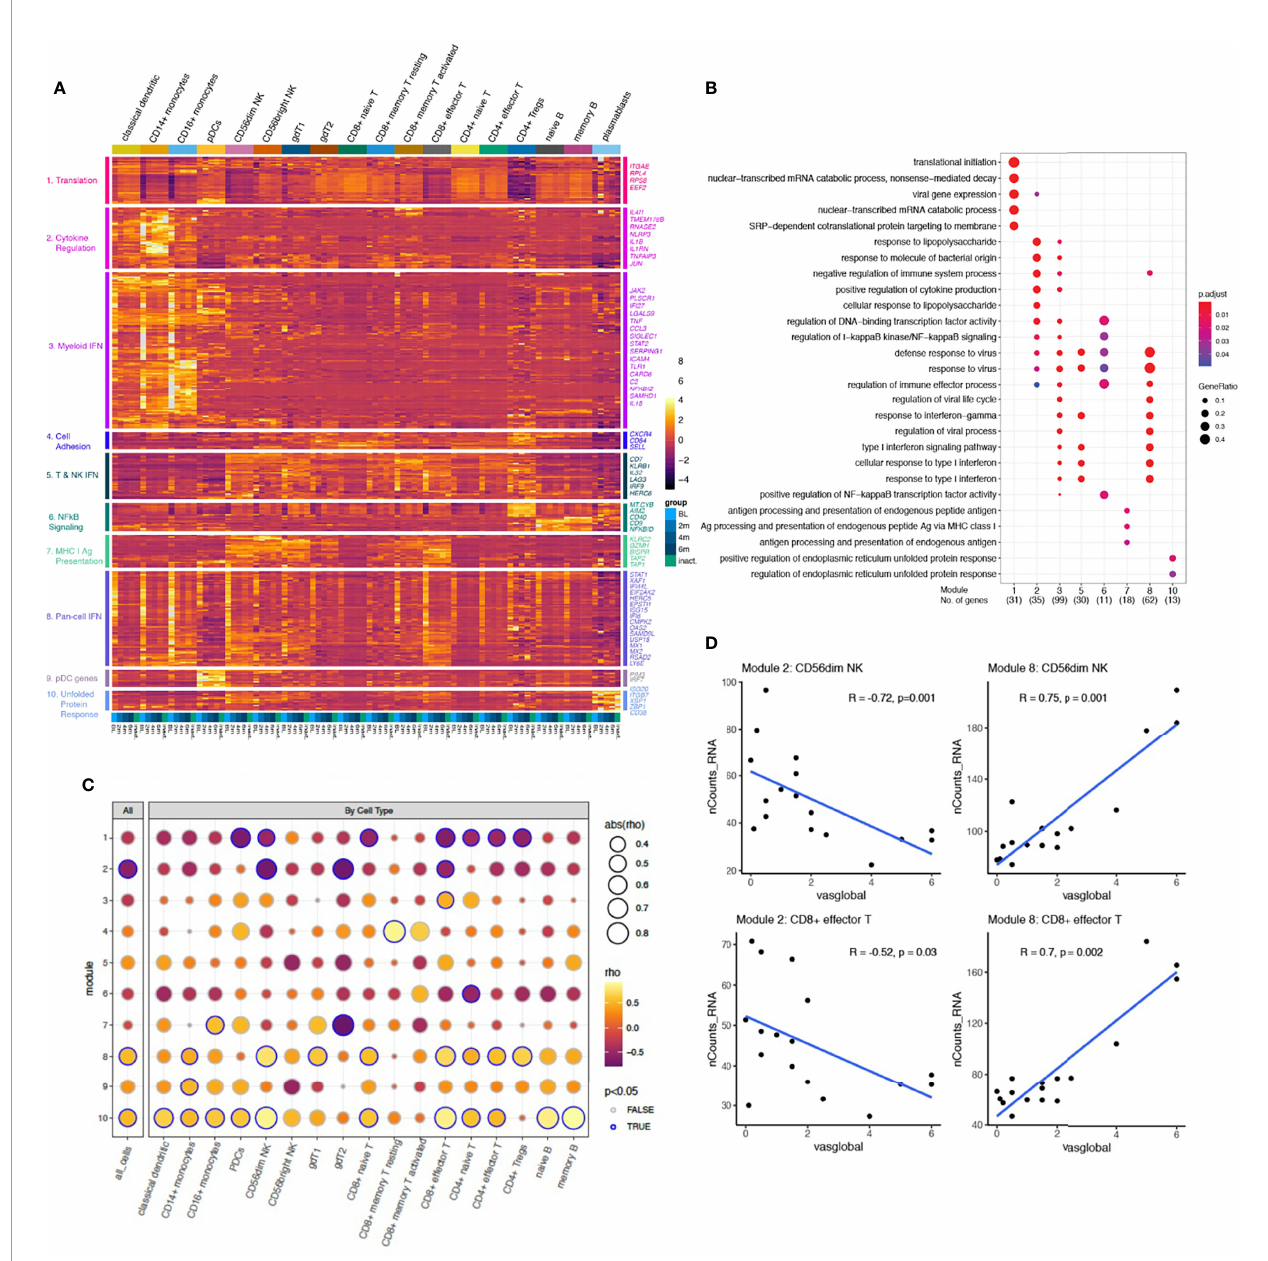
FIGURE 3 | (A) A heatmap displaying the mean expression of 368 genes differentially expressed in at least one cell type for each group per cell type ordered by increasing time from diagnosis (BL, 2m, 4m, 6m, inactive). Rows are clustered using unsupervised hierarchical clustering with k=10, and modules are annotated by enrichment terms on the left. A selection of genes from each module is annotated on the right. Color represents the normalized mean expression. (B) A dotplot displaying the association between each gene module set and enrichment of GO Biologic Processes terms. Each column represents a module from panel (A) . Enrichment analysis was performed using over-representation analysis with the color representing the adjusted p-value using B&H and the size of the dot representing the ratio of the number of genes relative to the number of genes in each term. (C) A dotplot displaying the strength of correlation between each module gene score, calculated as the average expression of all genes within a module, and the physician global VAS score for all cells together (left column) and each cell type individually. The correlations were calculated using a Pearson correlation. The size of each dot represents the strength of the association, the color represents the direction of the association, and the outline of the circle indicates signi fi cance de fi ned as P-value <0.05. (D) The Pearson correlation between the module gene score and physician global VAS plotted for each sample in CD8 + effector T and CD56 dim NK cells for modules 2 and 8. The blue line represents a linear model fi t for visualization